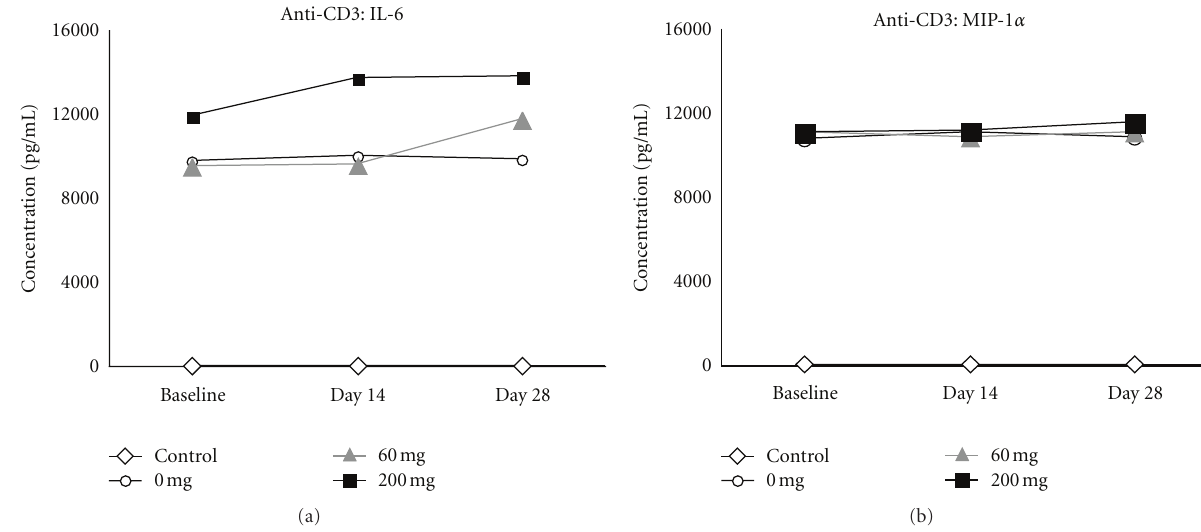
Figure 4: Treatment with RTL1000 did not induce immunosuppression. PBMC collected prior to and 14 and 28 d after infusion of drug from two subjects receiving 60 mg drug, three subjects receiving 200mg drug and one placebo subject was evaluated for levels of secreted IL-6 (a) and MIP-1 α (b) in supernatants collected 48h after stimulation with anti-CD3 mAb or in unstimulated Control cultures. No significant changes were observed at either postinfusion time point.